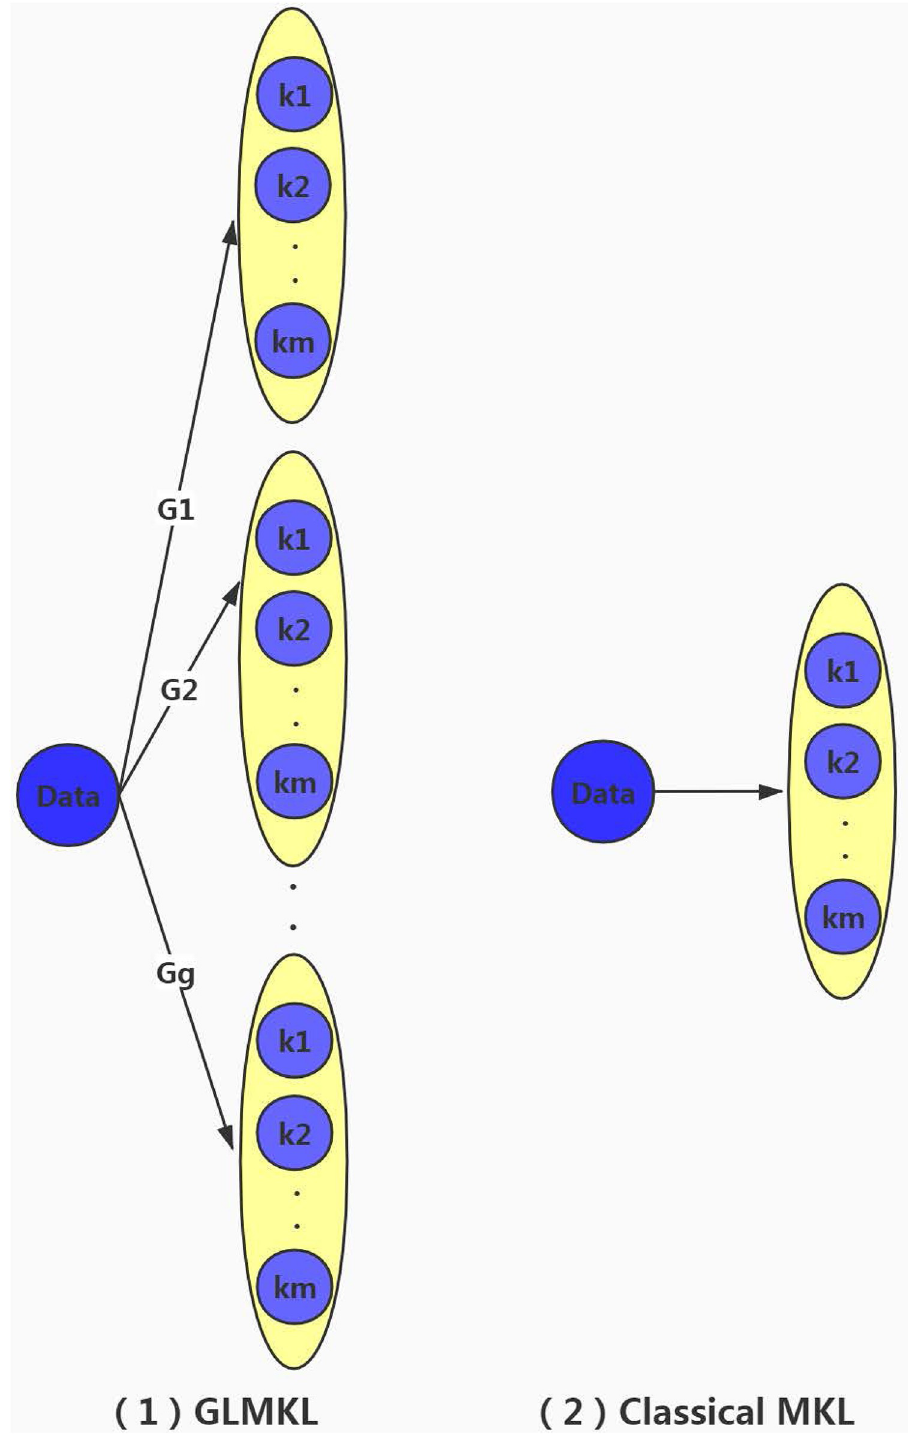
Fig 1. Comparison of two multiple kernel learning methods.